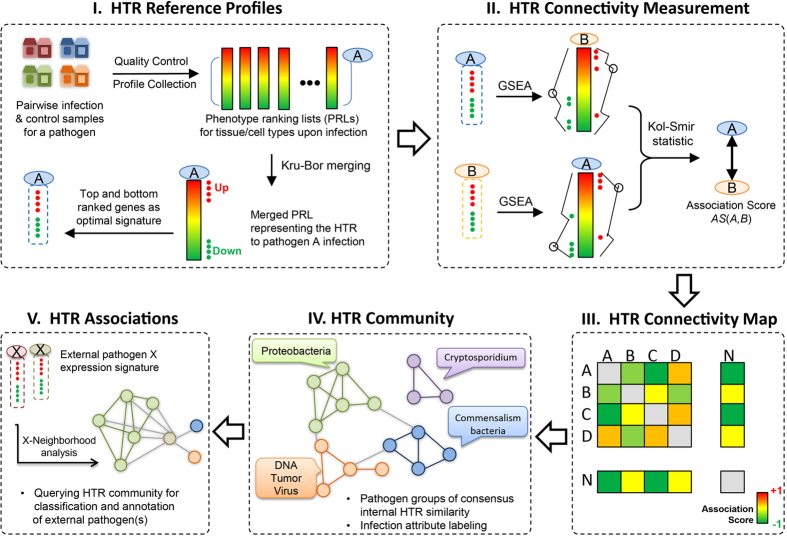
HTR Connectivity Map development work flow.A group of 1,353 expression profiles generated from infection of cultured human cells with 50 clinically important pathogens were collected from Gene Expression Omnibus and used to populate a reference database. A single synthetic PRL (22,160 genes ranked according to their differential expression relative to the control) was computed to represent consensus and common HTRs to infection with a pathogen across different cell lines and from different laboratories. GSEA was used to score each reference profile for the direction and strength of enrichment with the query reference signature. The connectivity of HTRs between pathogen pairs was then presented in a map/matrix, with positive scores indicating functionally similar HTRs and negative scores indicating opposing HTRs. Through clustering, 50 pathogens were grouped into eight HTR communities (i.e., pathogens that induce more consensus HTRs). Characteristic infection attributes and gene expression patterns were identified for each HTR community. HTR community reliability for demonstrating associations among pathogens was tested with query signatures of HTRs to external pathogens.